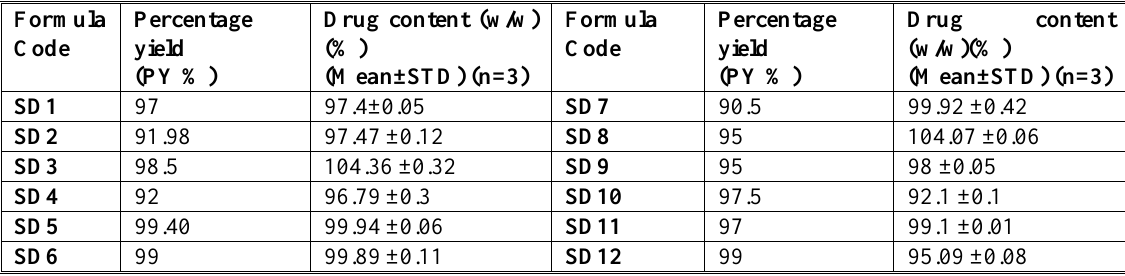
Table2. Percentage yield and drug content of SD.